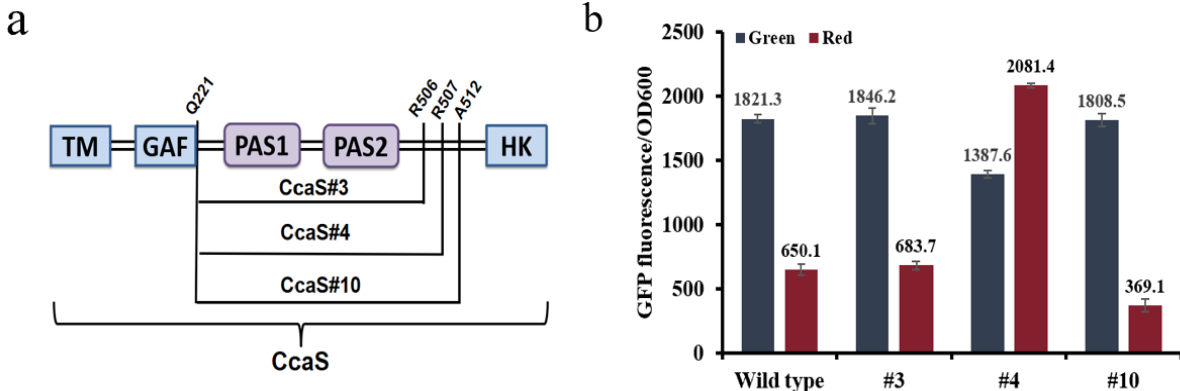
Figure 1. ( a ) Construction of CcaS #3, #4 and #10 variants. ( b ) The fluorescence intensity of cells grown under green light and red light. The fluorescence intensity was acquired 9 h after inoculating the cultures into 24-well plates with a starting OD 600 of ~0.1. The cultures were exposed to different light to characterize the different expression levels. The basic OD 600 and fluorescence were eliminated. Bars indicate relative fluorescence intensity when compared with the normalized fluorescence level of the wild-type system. Data represent the mean ± SD from three independent experi- ments ( n = 3).